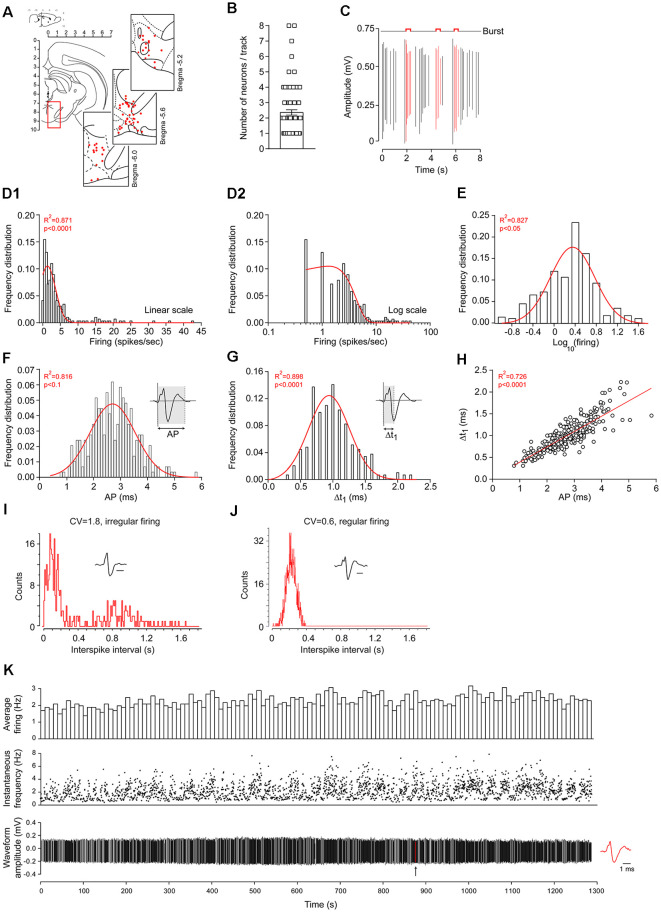
Dataset acquired using in vivo extracellular recordings of ventral tegmental area (VTA) neurons in anesthetized rats. (A) VTA location on a rat coronal brain section, adapted from Paxinos and Watson (2007). Insets: examples of coordinate locations of some neurons, reconstructed from stereotaxic measurements. All units are in mm. (B) Number of spontaneously-active neurons encountered during electrode descents. (C) Representative example of burst activities during in vivo extracellular electrophysiology. Red action potential (AP) waveforms are included within burst events while black AP waveforms are outside of burst events. Firing-rate distributions using linear (D1) or logarithmic (D2) scales. Firing-rate logarithmic values (E). Red curves represent fitted Gaussian curves. Note that firing rates are skewed (asymmetric Gaussian, in D1,D2) but also lognormally-distributed (symmetric Gaussian, in E). Across the 291 neurons, AP (F) and Δt1
(G) durations were normally distributed. The direct linear relationship between AP and Δt1 durations (H). Representative inter-spike interval distributions and AP waveforms of regularly (I) and irregularly (J) firing neurons. The horizontal bars represent 1 ms. Note the differences in coefficient of variation (CV; firing rate coefficient of variation). (K) Typical recording example of VTA dopaminergic (DA) neurons, displaying a stable firing rate over time. The arrow indicates the location of the AP waveform represented on the right.